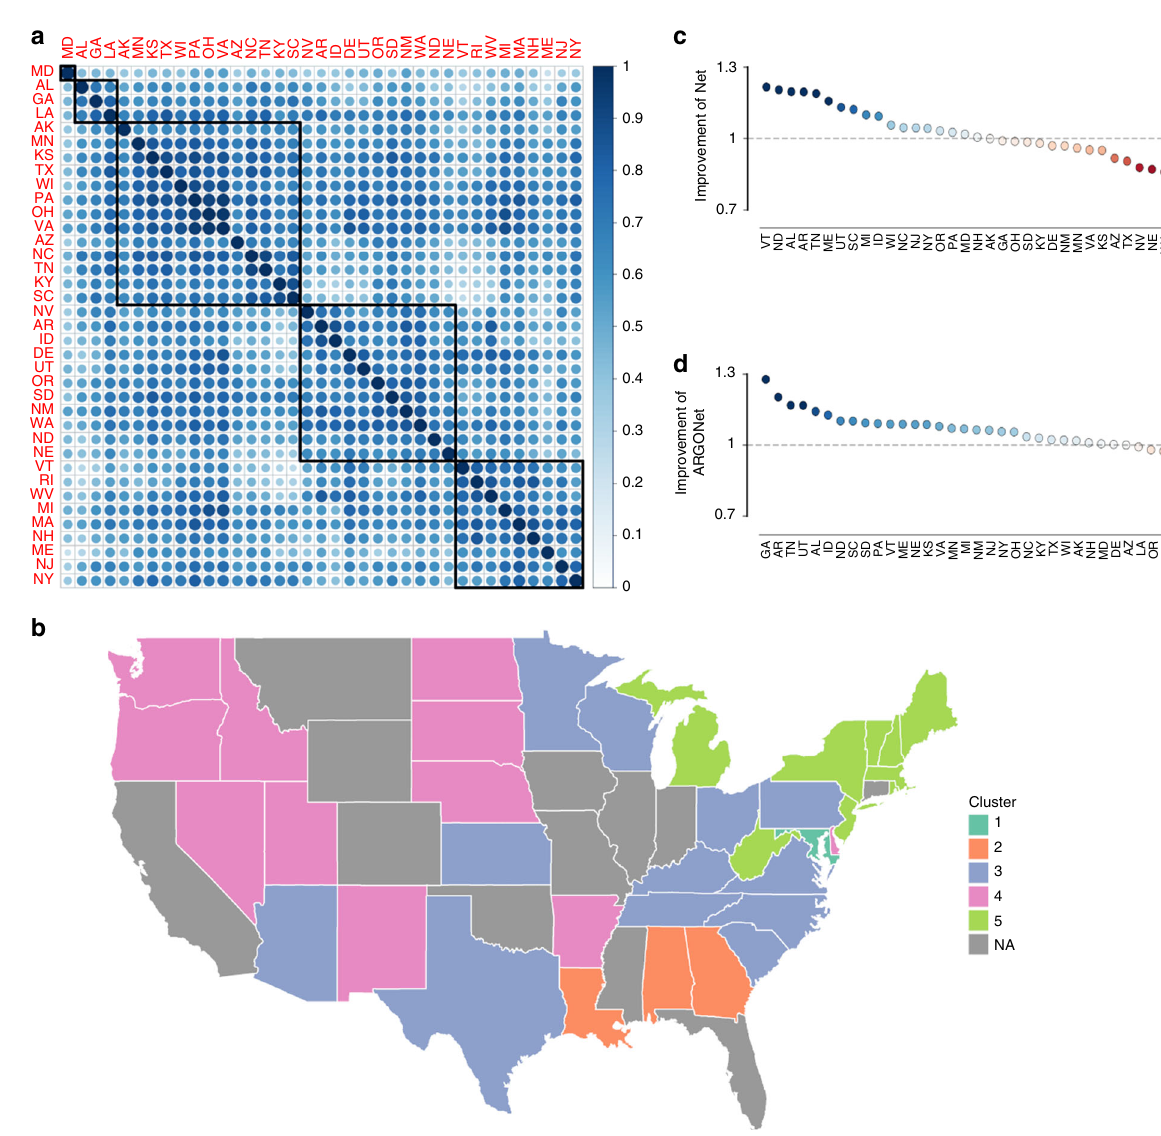
Fig. 2 Motivation for developing spatio-temporal network and ensemble approaches. a Heatmap of pairwise %ILI correlations between all states in the study over the period September 30, 2012 to May 14, 2017. Five clusters of intercorrelated states are denoted by black boxes. b Geographic distribution of the fi ve identi fi ed clusters. c RMSE improvement of Net over ARGO over the period September 28, 2014 to May 14, 2017. The improvement of Net is here de fi ned as the inverse RMSE ratio of Net and ARGO, so values above 1 indicate improvement. d RMSE improvement of ARGONet over ARGO over